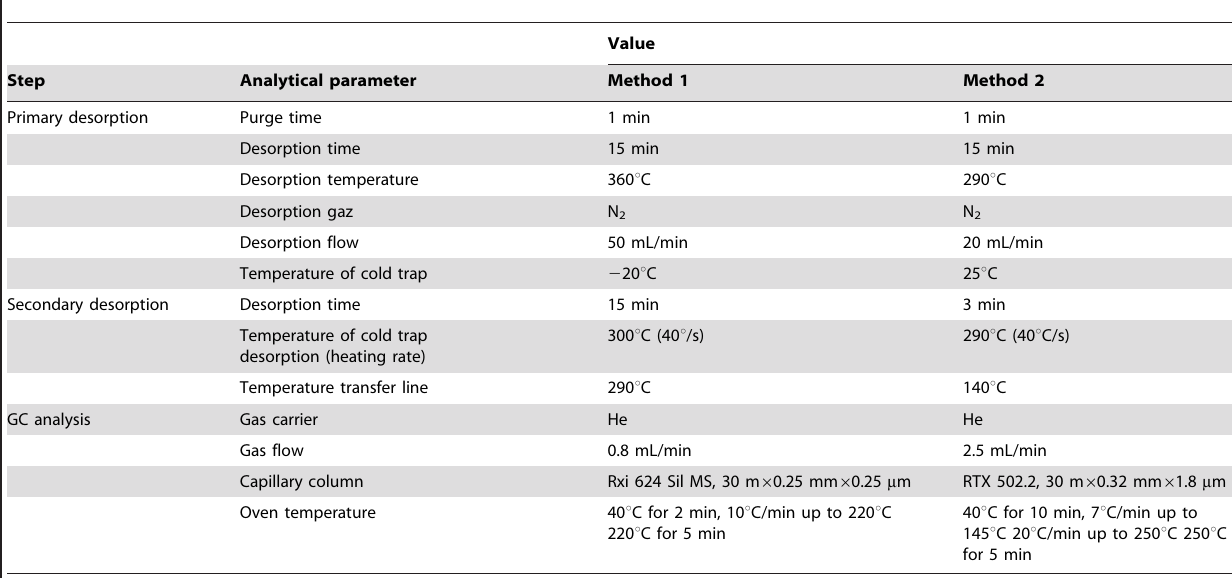
Table 1. Parameters for ATD/GC/MS analysis of the method 1 and